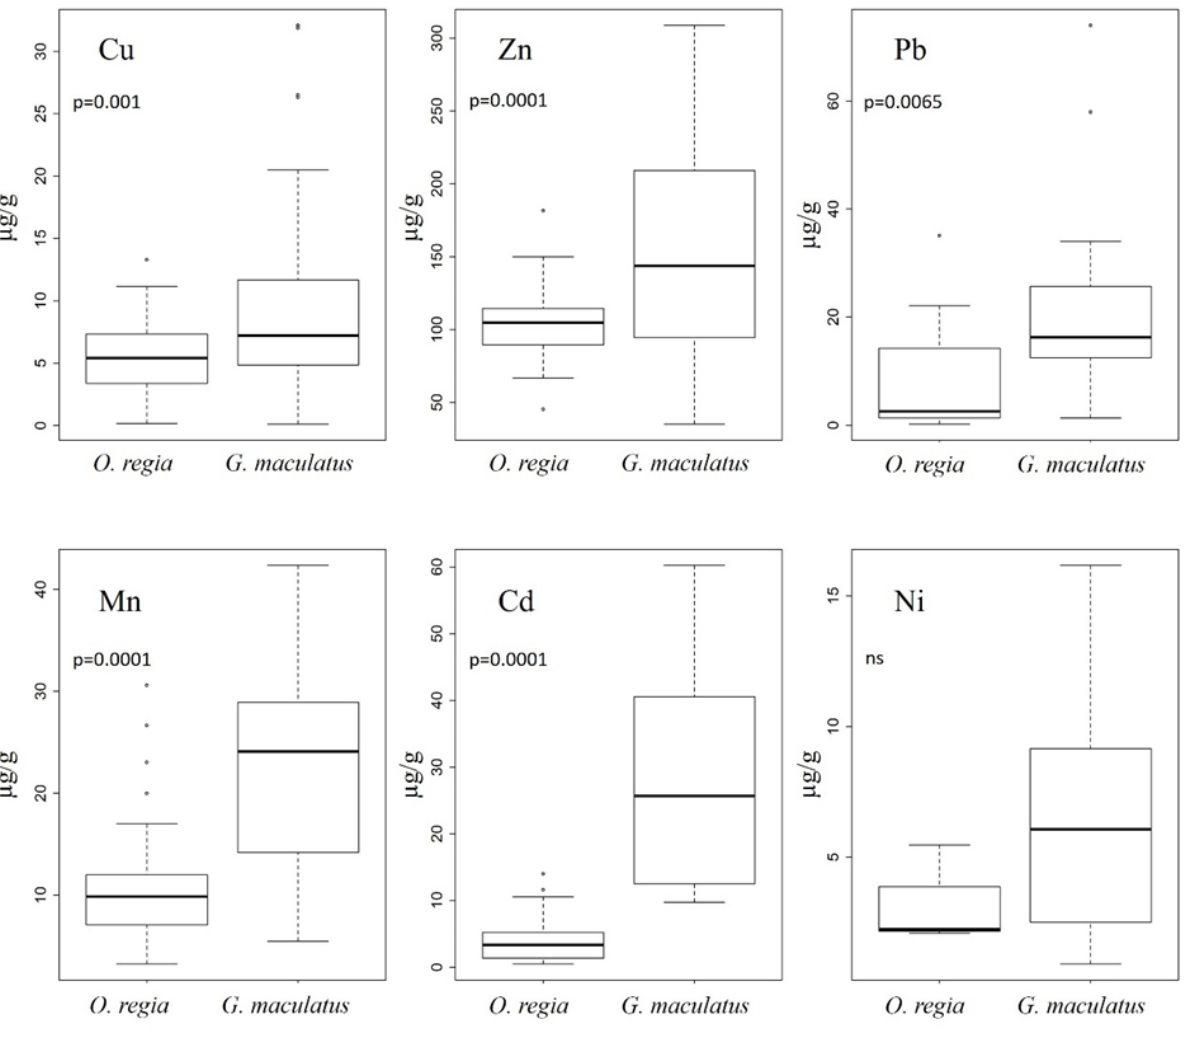
Figure 2. Boxplots of Cu, Zn, Pb, Mn, Cd, and Ni concentrations in samples of Odontesthes regia and Galaxias maculatus collected from the Valdivia estuary. Boxplots show the maximum and minimum as well as the interquartile ranges (25–75%) with solid lines representing median values .